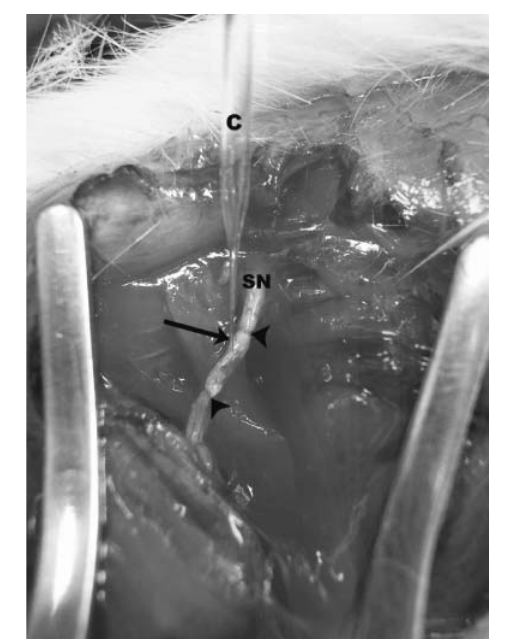
FIGURE 1 - Photograph of the